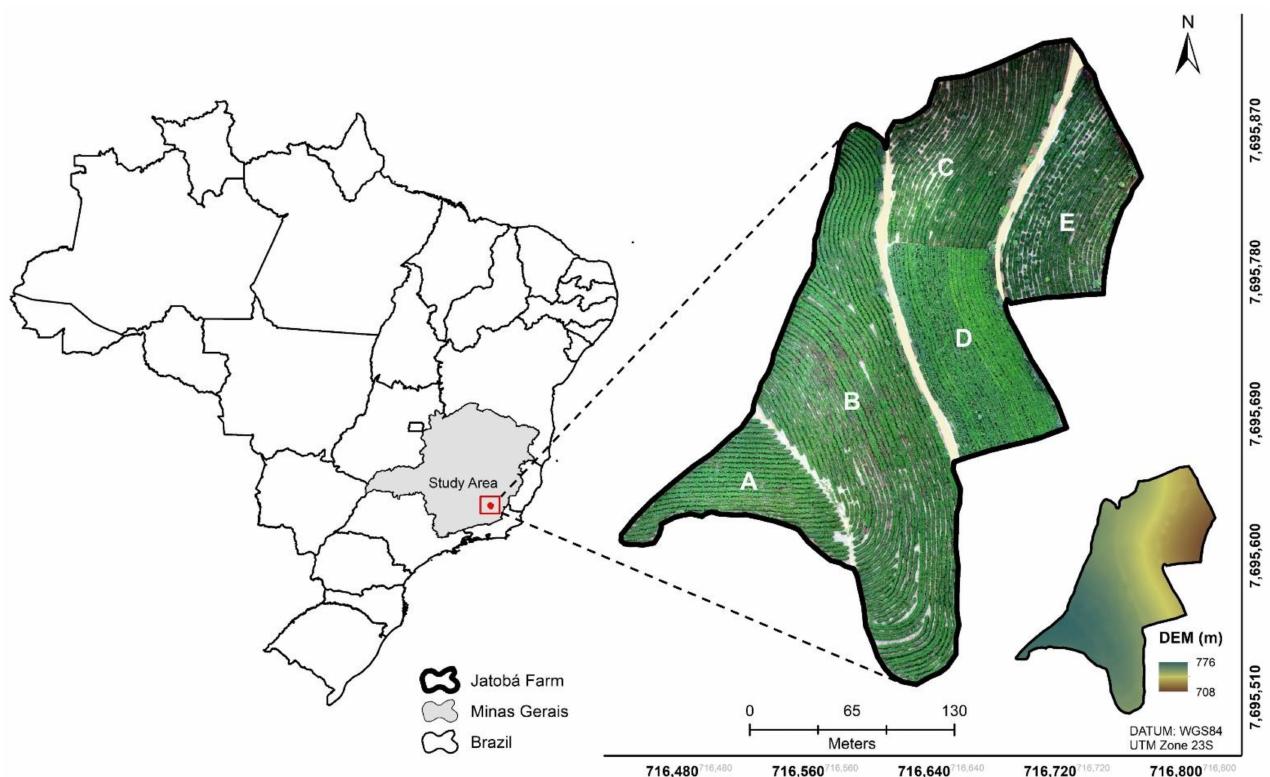
Figure 1. Location of the study area in Minas Gerais State, Southeastern